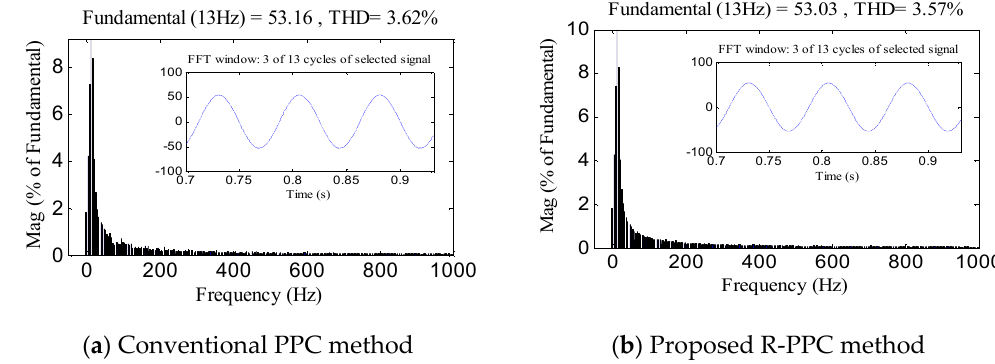
FFT window: 3 of 13 cycles of selected signal